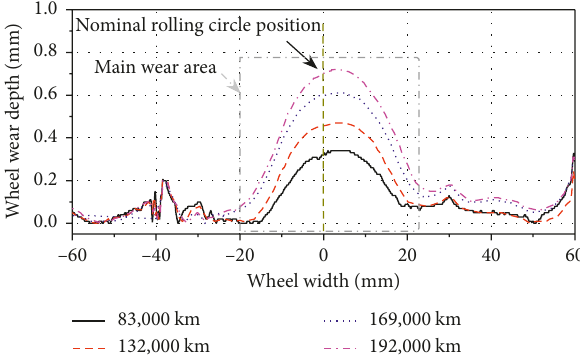
Figure 10: Comparison of measured wheel hollow wear depth for different travelling